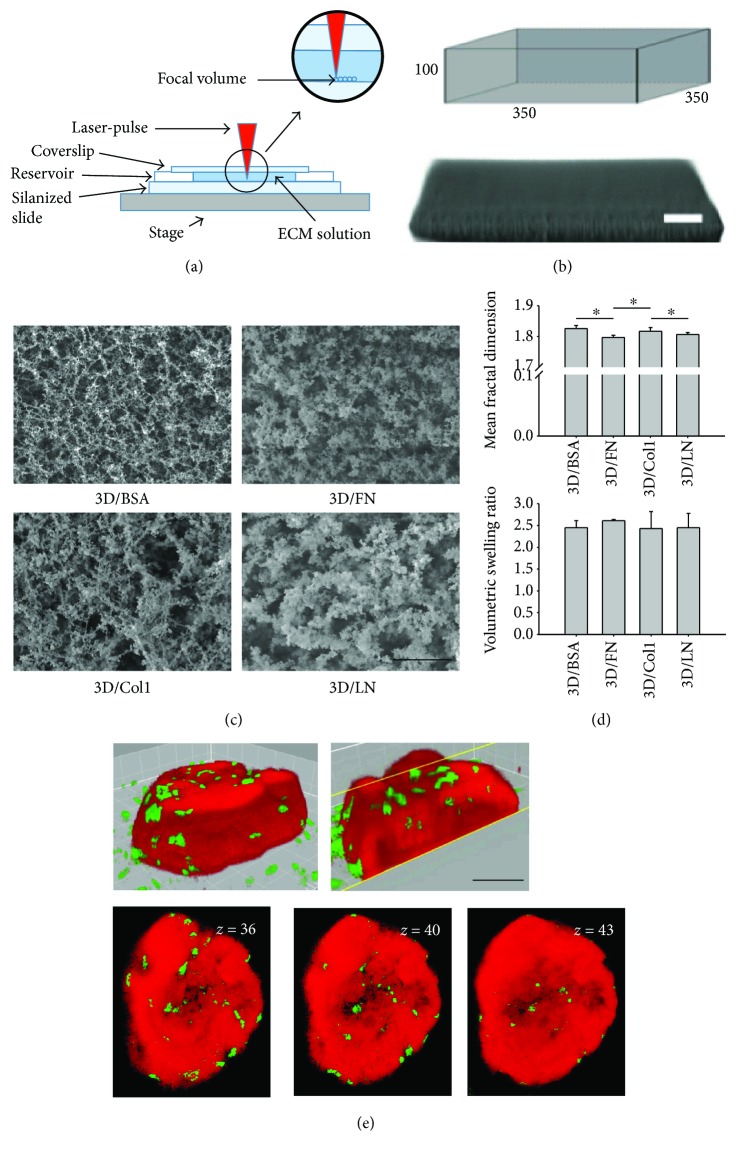
Fabrication of 3D ECM-based, bioprinted prisms. (a) Fabrication Schematic. Multiphoton excitation was used to polymerize a focal volume containing individual ECM proteins (e.g., FN, Col1, and LN) and associated photocrosslinking agent. 3D printing of this type was used so that a three-dimensional construct, in this case a rectangular prism, could be generated even with ECM types that do not form hydrogels spontaneously ex vivo. (b) Geometric template (above; dimensions of micron scale) and associated bioprinted ECM-based rectangular prism containing BSA and LN (BSA/LN; below). Scale bar = 50 μm. (c) Representative SEM images of prisms fabricated with BSA, FN, Col1, and LN. Scale bar = 10 μm. (d) Average fractal dimension of each ECM-based, 3D bioprinted prism (above); volumetric swelling ratio of each ECM-based bioprinted prism (below). Error bars depict standard deviation (SD), ∗
P < 0.05, n = 3 experimental replicates. (e) Multiphoton imaging to show interaction of hMSCs with bioprinted prism containing BSA only after 3 days of seeding. 3D reconstruction (left) and cut-away view (right) show cellular infiltration (e, upper panels). Also, in support of hMSC infiltration are shown multiple cross sections at various z depths (e, lower panels). Green (CD90) indicates MSCs; red indicates the bioprinted matrix. Scale bar = 100 μm.